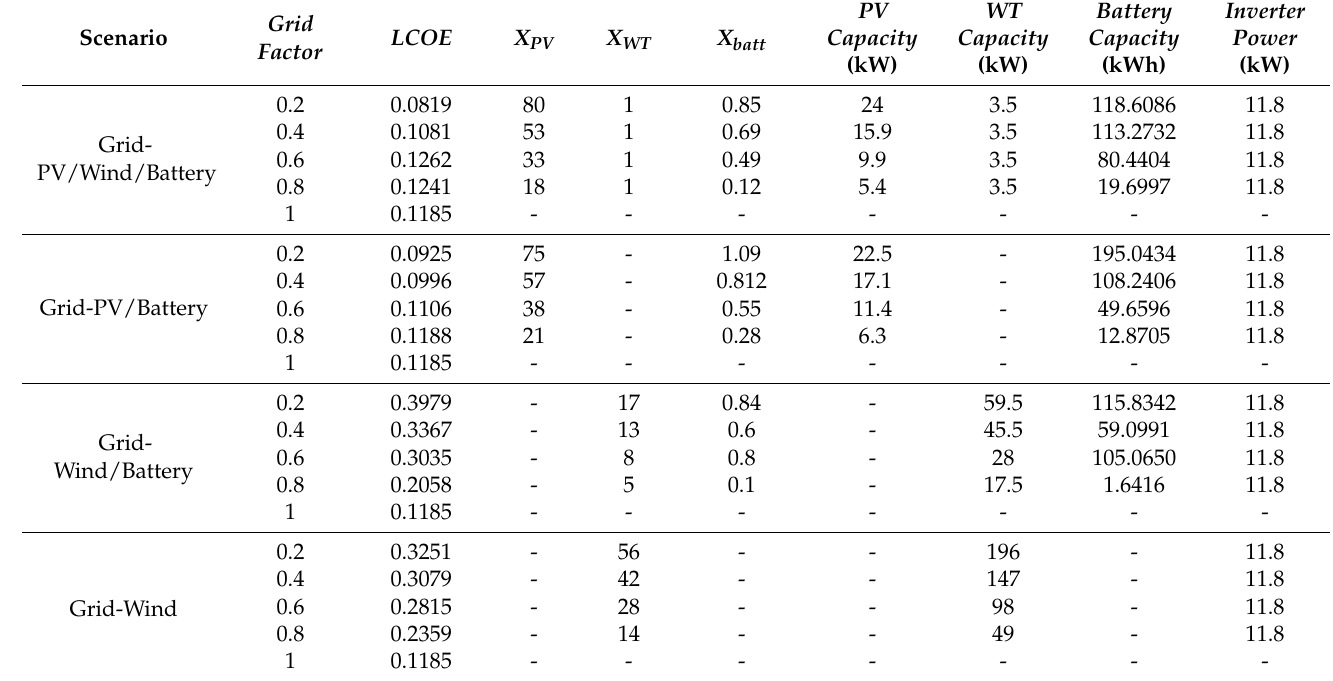
Table 12. Grid-connected RES submitted to variable grid energy